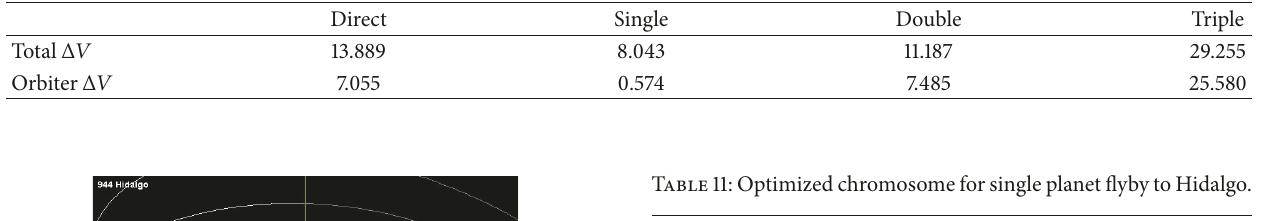
Table 10: Mission Δ𝑉 to Hidalgo for multiple flyby scenarios.